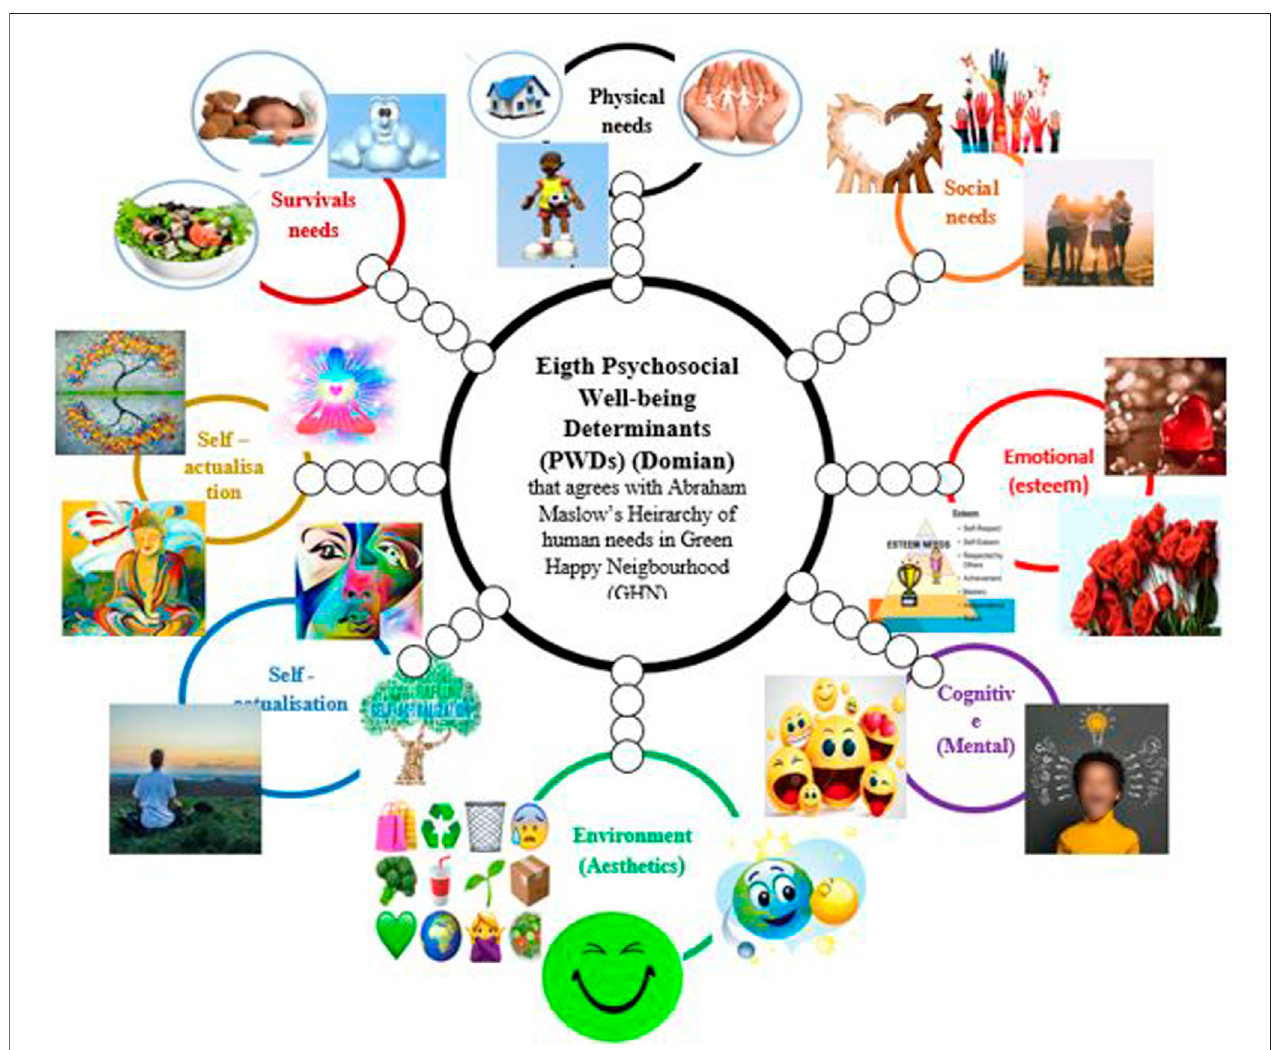
FIGURE 5 | Psychosocial well-being concept of a green neighbourhood; source: Authors, (2022).